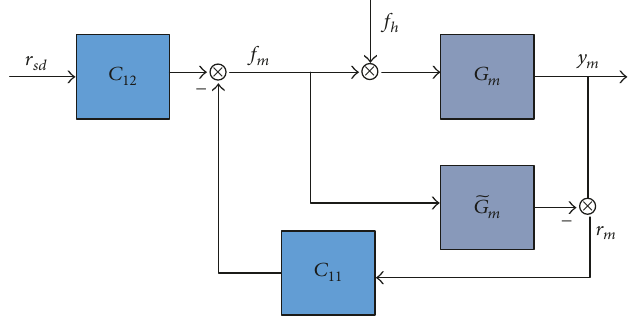
Figure 1: IMC structure of the master subsystem.